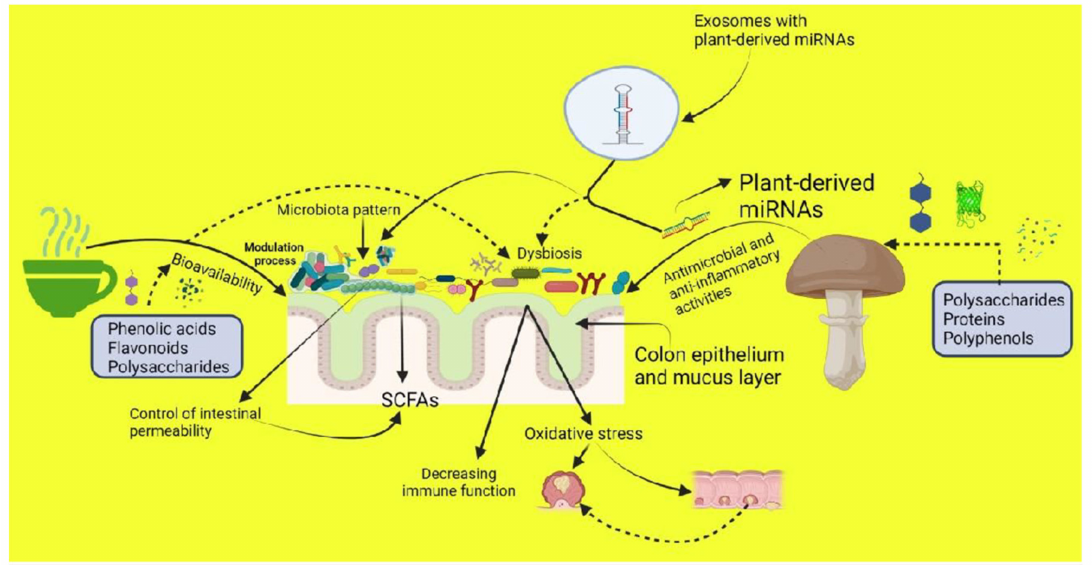
Figure 1. The action of herbal teas and mushrooms consumption effects on gut microbiota bioactivities. The figure was drawn using bioRender Premium Edition (https://app.biorender.com/; accessed on 10 May